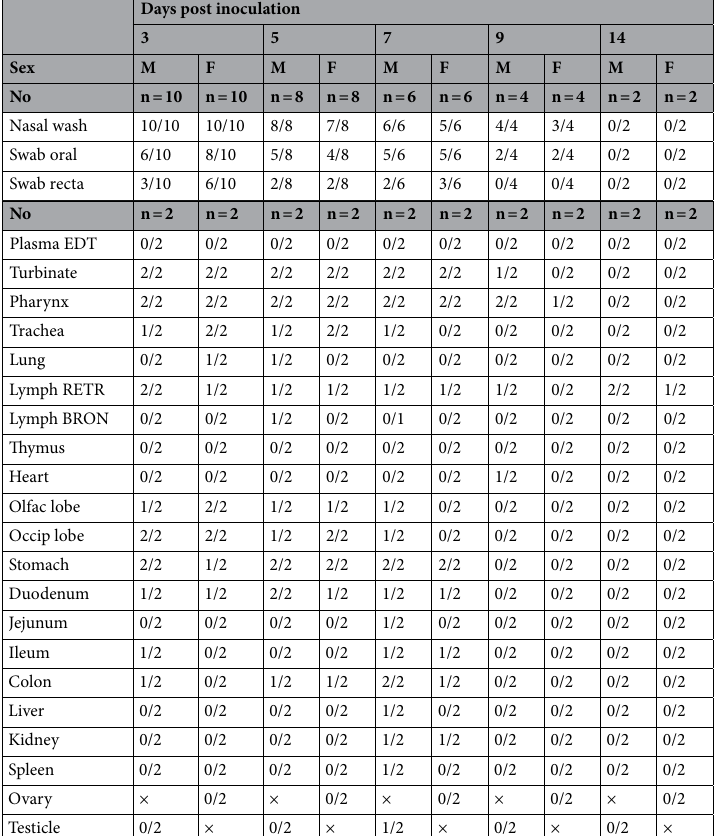
Table 1. Detection of SARS-CoV-2 RNA in nasal washes, swabs (oral and rectal), blood and tissues in ferrets infected with SARS-CoV-2 following intranasal challenge. For each sample type the numerator shows the number of qRT-PCR positive samples and the denominator shows the total number of samples tested. LYMPH RETR the retropharyngeal lymph node, LYMPH BRON the bronchial lymph node, OLFAC LOBE the olfactory bulb, OCCIP LOBE the occipital lobe respectively. × indicates not